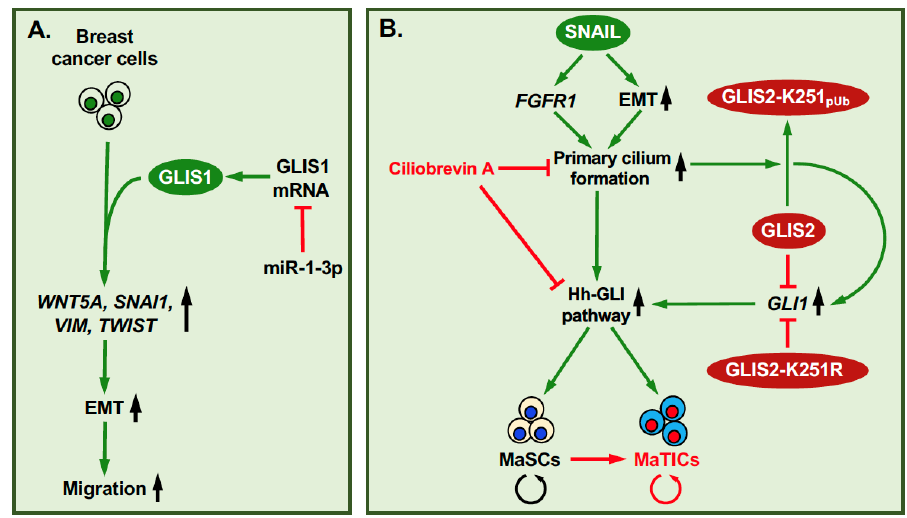
Figure 2. Roles of GLIS1 and GLIS2 in breast cancer. ( A ) Expression of GLIS1 in breast cancer cells increases the expression of EMT promoting genes, such as SNAI1 , VIM , WNT5A , and TWIST , thereby promoting cell migration. MiR-1-3p inhibits the expression of GLIS1 and EMT. ( B ) Schematic of the interplay between SNAIL, primary cilium, regulation of GLIS2 repressor activity, and stem cell renewal. SNAIL induces GLIS2 polyubiquitination at K251 through a primary cilium-dependent mechanism that involves stimulation of EMT and FGFR1 expression. This polyubiquitination causes loss of GLIS2 repressor function, and subsequent activation of GLI1 and WNT genes and increased stem cell renewal [11]. These actions are inhibited by ciliobrevin A, a ciliogenesis and hedgehog pathway inhibitor. GLIS2-K251R functions as a constitutive repressor and inhibitor of stem cell renewal.